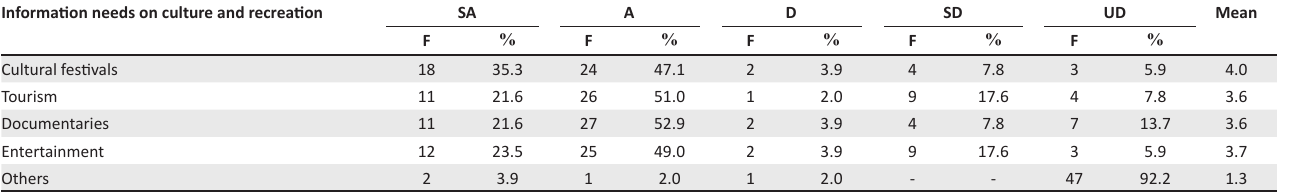
TABLE 10: Opinions of the heads of branch libraries on culture and recreational information needs of the rural dwellers ( N = 51). Information needs on culture and